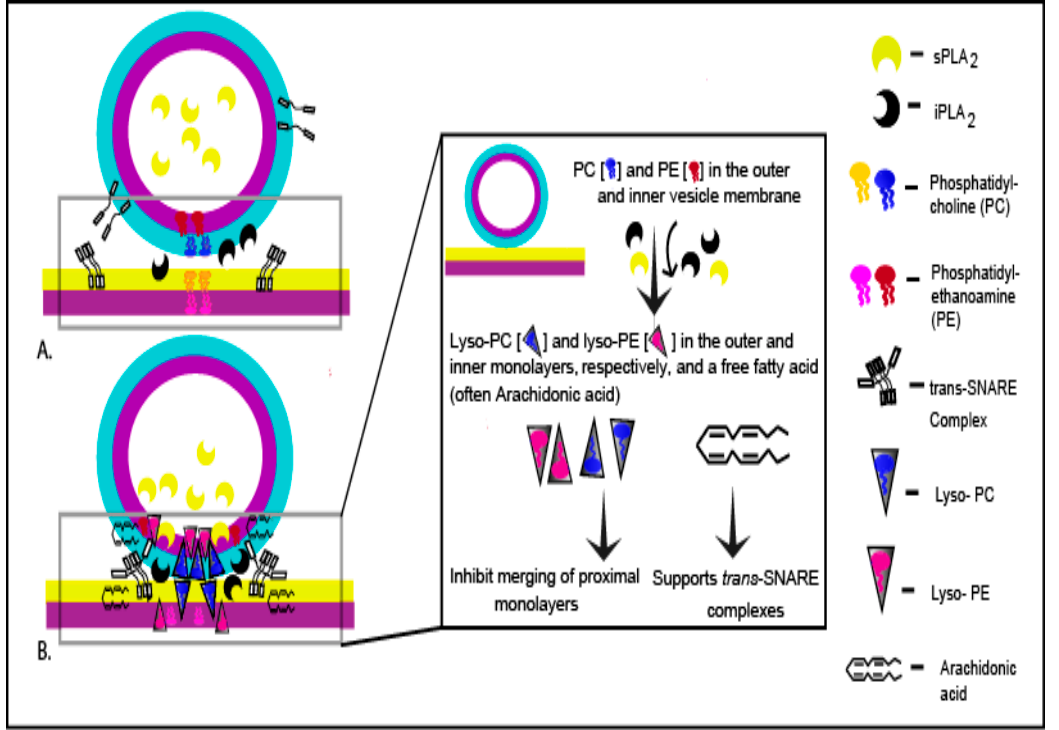
Figure 9. Working hypothesis: ( A ) Non-contacting membranes ( B ) Vesicle docked with the plasma membrane (PM). At basal rate, the vesicle luminal sPLA 2 and membrane bound iPLA 2 cleave PE and PC in the inner and outer monolayer, respectively; PM bound iPLA 2 also cleaves PC in the inner monolayer of the PM. This causes a local increase in LPC at the membrane contact site that is balanced by intermittent LPE production at the adjacent inner membrane via transient sPLA 2 activity. This mechanism may thus act as a native fusion ‘brake’ and the released FFA (often Arachidonic acid) may support trans SNARE complex formation to ensure and maintain e ffi cient priming / docking. (adapted from [29] with